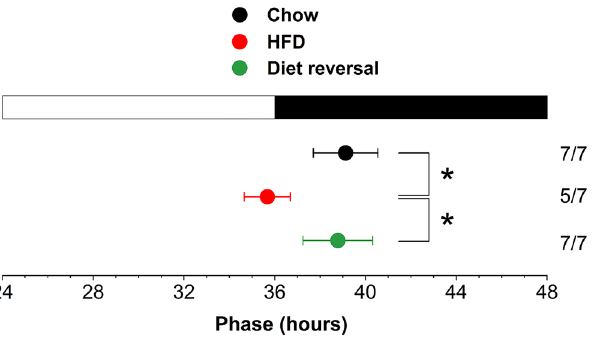
Fig 3. The phase of the liver clock is restored by diet reversal after chronic high-fat diet consumption. Male heterozygous PER2::LUC mice were fed either chow for 5 weeks (black circle), high-fat diet for 5 weeks (red circle), or high-fat diet for 4 weeks and then chow for 1 week (green circle). The mean ( ± SD) phases were determined from the peaks of PER2::LUC expression in liver explants during the interval between 12 and 36h in culture and were plotted relative to the time of last lights on (24h is lights on and 36h is lights off, white and black bar on top; liver cultures were prepared at ZT11). The sample size is shown (number of rhythmic tissues/number of tissues tested). * p <